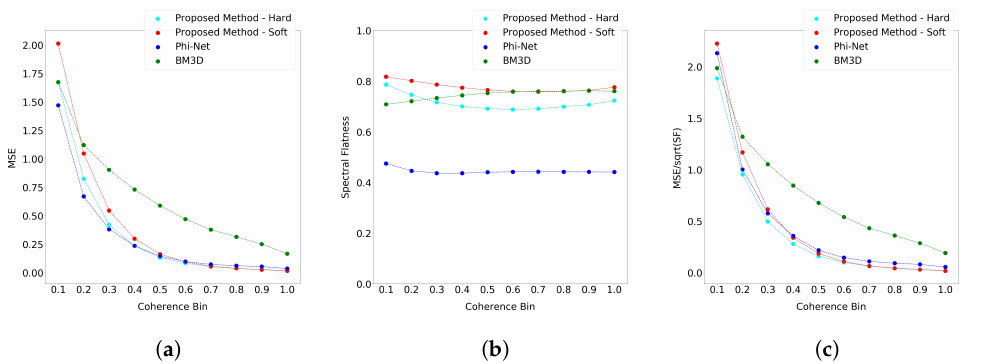
Figure 13. Low-frequency case: mean square error ( a ), spectral flatness ( b ) and custom metric ( c ) for all methods under